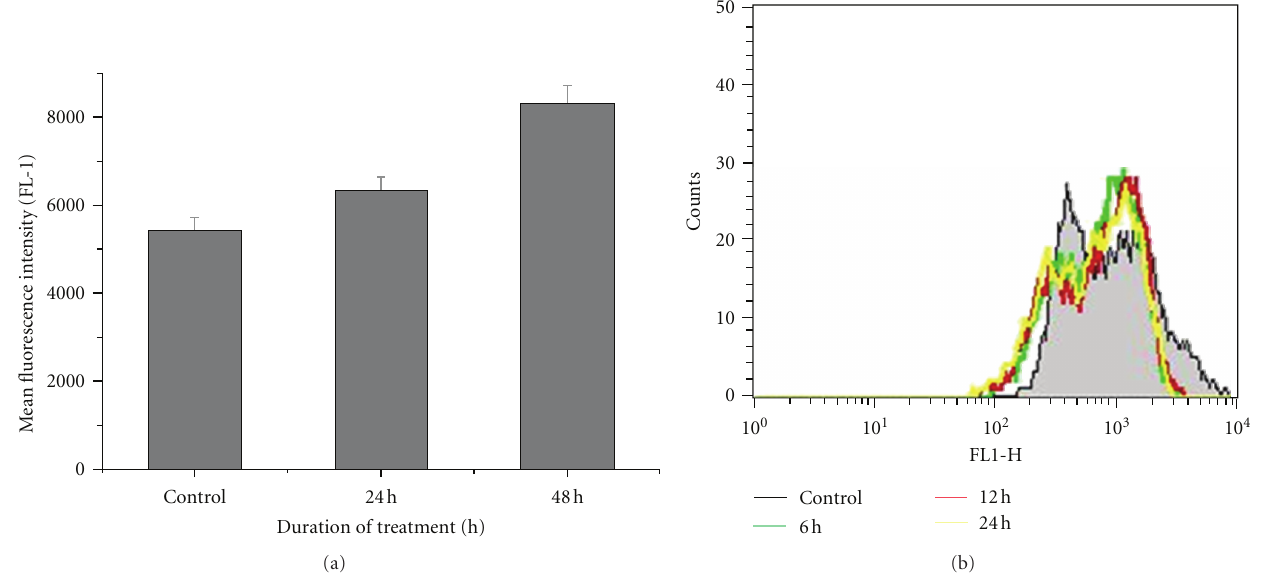
Figure 3: ROS generation and mitochondrial membrane potentials ( Ψ m ) of ca ff eic-acid-treated cells. (a) HCT 15 cells were cultured in the presence or absence of ca ff eic acid for the specified time points. DCFDH-DA fluorescence intensity was detected by using flow cytometry. Data shows the mean and standard error of three independent experiments. (b) HCT 15 cells were treated with ca ff eic acid for specified time- periods and then Ψ m were determined using rhodamine 123 by flow cytometry. Data is representative of three independent experiments.